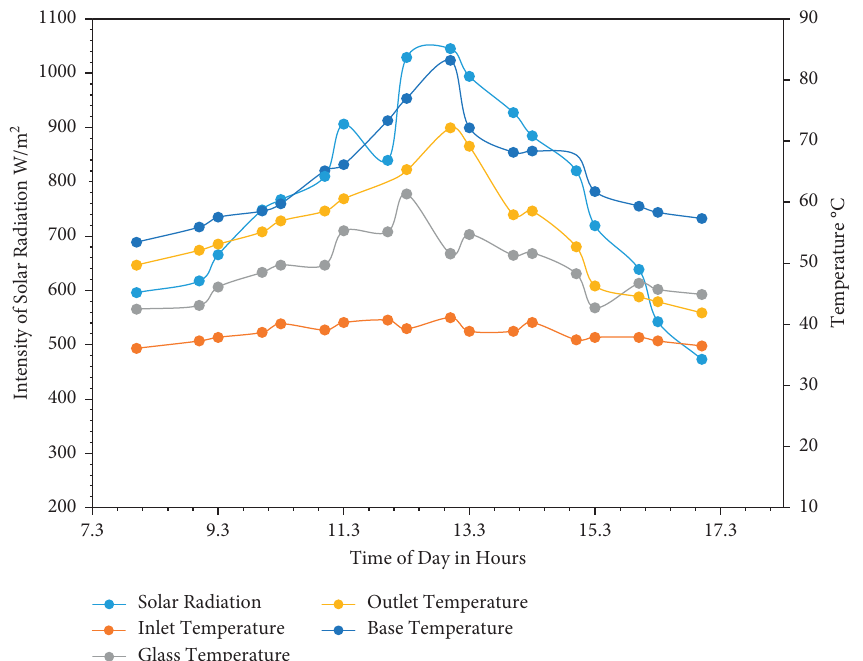
Figure 5: Hourly variations of solar radiation and temperature of air, glass, and absorber plate on day time in